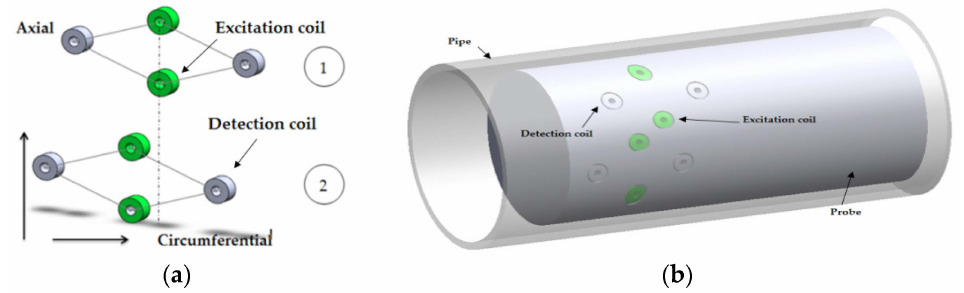
Figure 7. General setting for a C-3 probe: ( a ) Excitation and detection coil configuration; ( b ) illustration of the excitation and detection coil location on the eddy current testing probe for a